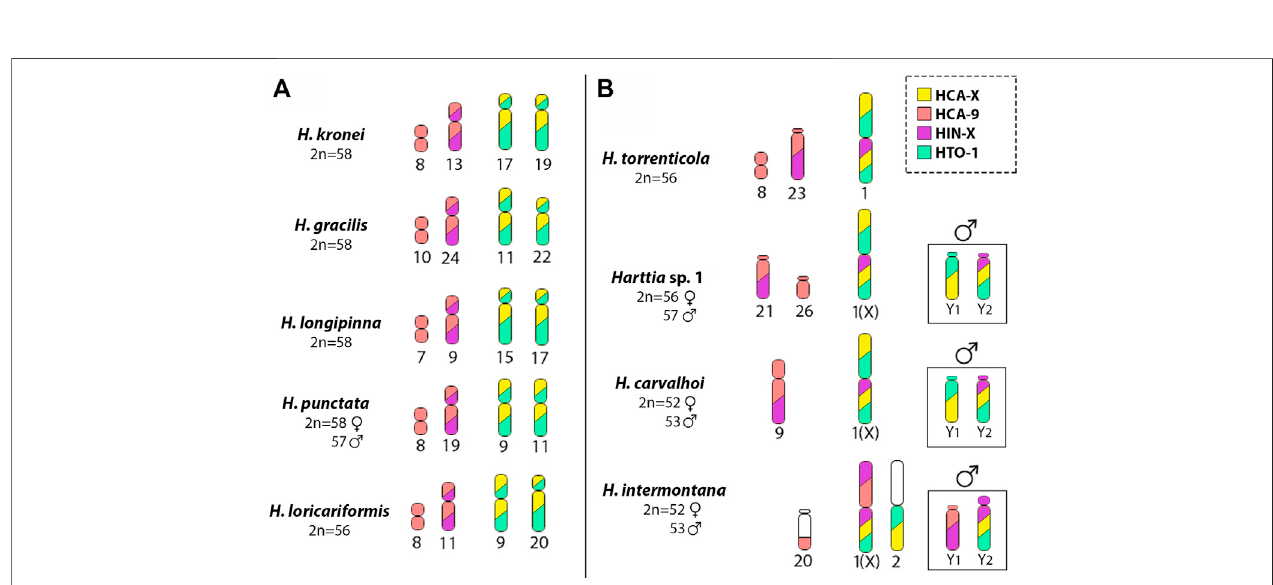
FIGURE6| SchematicrepresentationsummarizingthedistributionoftheWCPprobesobtainedinthisstudy:HCA-X(yellow),HCA-9(lightpink),HIN-X(purple)and HTO-1(green)in Harttia species (A) withoutthelargestmetacentricchromosomepair- H.kronei,H.gracilis,H.longipinna,H.loricariformis, and H.punctata -and (B) with the largest metacentric pair in the karyotype - H. carvalhoi, H. torrenticola, H. intermontana and Harttia sp. 1. The highlighted boxes show the male condition and the differentcomposition oftheY 1 and Y 2 chromosomesin H. carvalhoi, H.intermontana and Harttia sp. 1. Note theoverlapping oftheHCA-9 and HIN-X probes (light pink and purple), and the HCA-X and HTO-1 (yellow and green) probes.